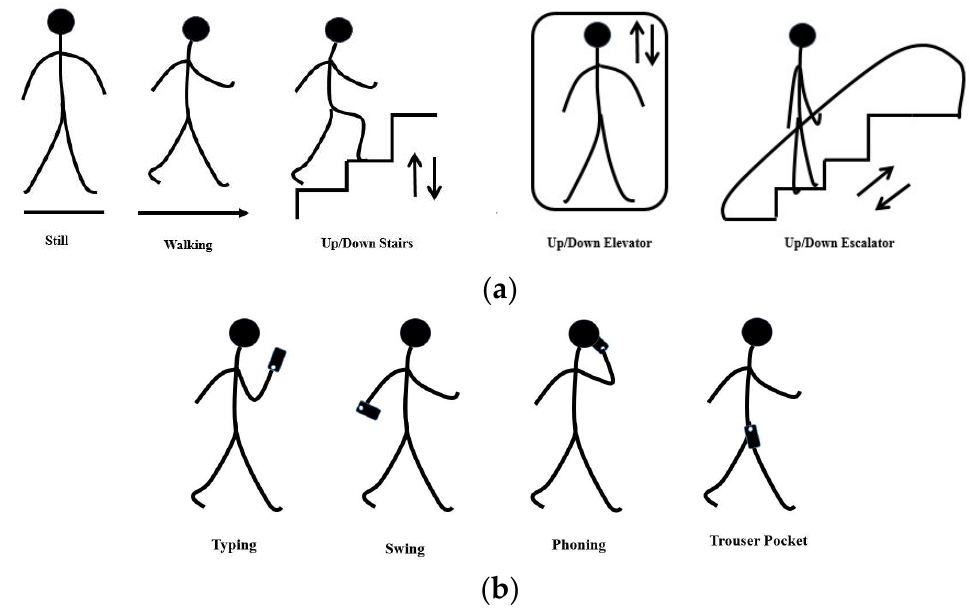
Figure 2. ( a ) Human motion modes and ( b ) pose patterns covered in this study.